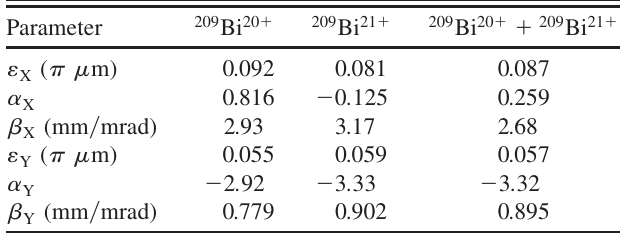
TABLE I. The rms normalized emittances and Twiss parame- ters of individual charge states ð 20 þ ; 21 þÞ and combined bis- muth beams at the end of the LEBT.